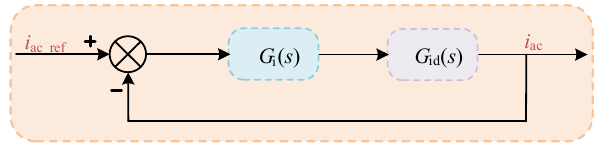
Figure 10. Structure of current inner loop controller.